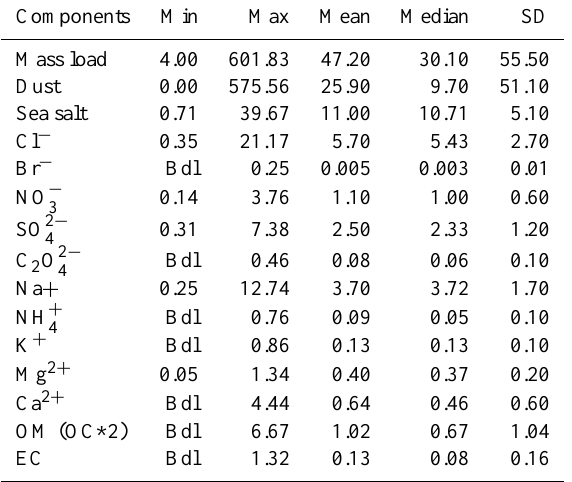
Table 2. Minimum, maximum, 5 year average and standard devia- tions (µgm − 3 ) of PM 10 aerosol components at